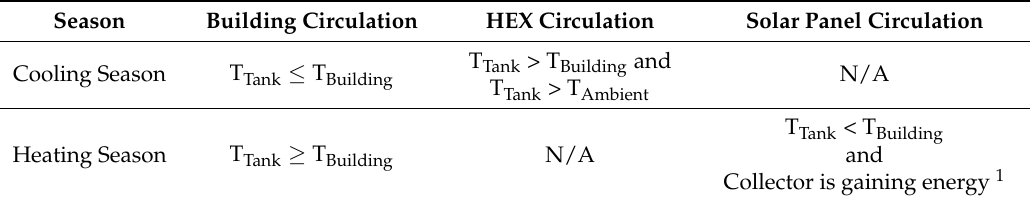
Table 5. Tank Circulation Regime. HEX: heat